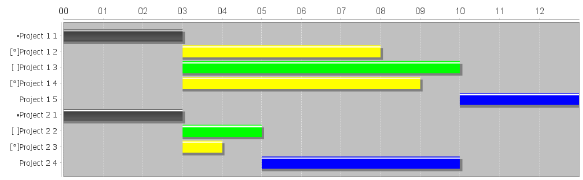
Figure 2: Project execution schedules in the example with reserving availability of resources on site according to the SPT